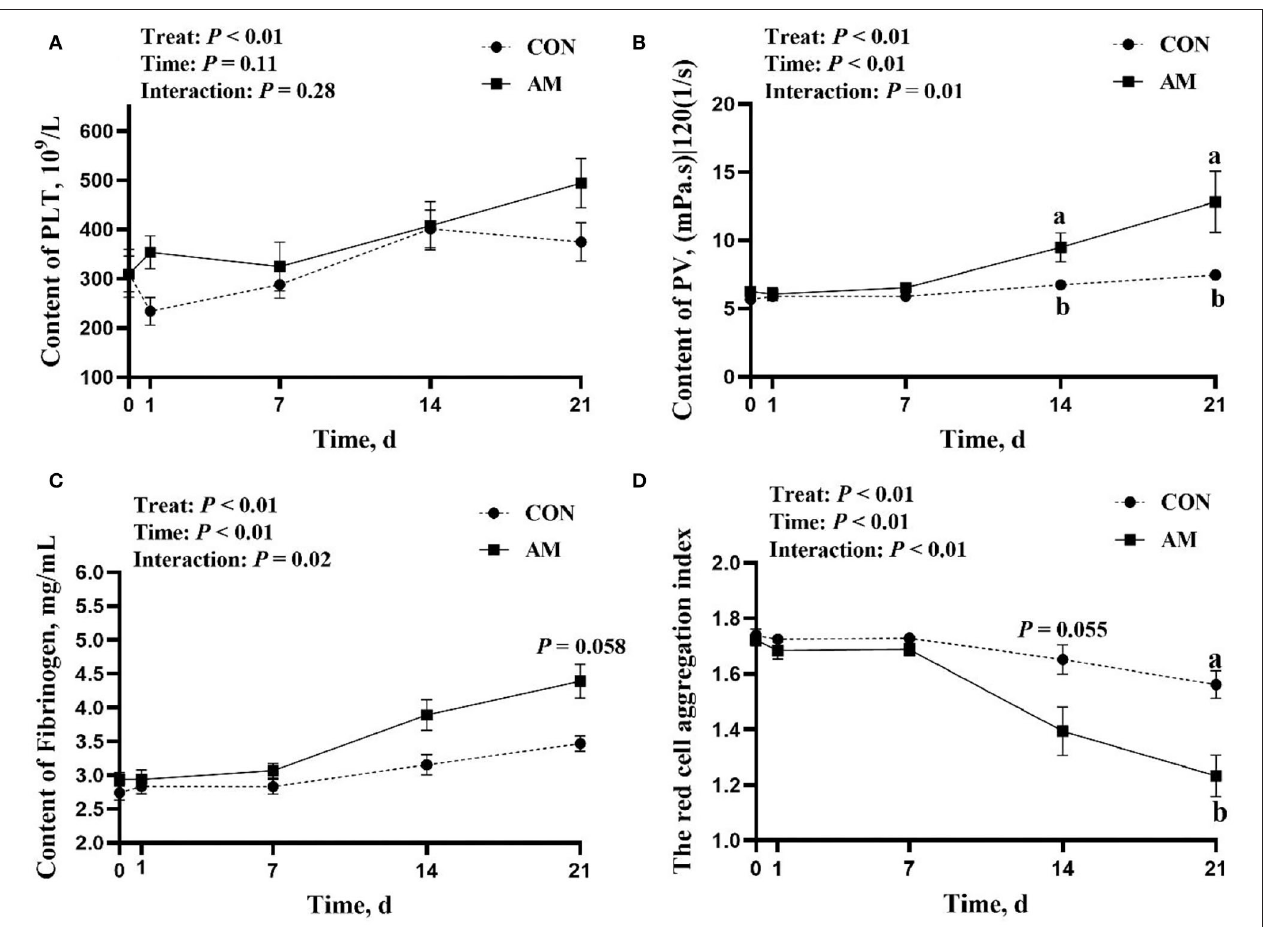
FIGURE 1 | Coagulation index of CON and Astragalus membranaceus (AM) in Holstein dairy cows at 21 days postpartum. (A) Platelet count, (B) Plasma viscosity, (C) Plasma fibrinogen, and (D) The red cell aggregation index. Data shown are means ± SEM. Different lowercase letters indicate significant